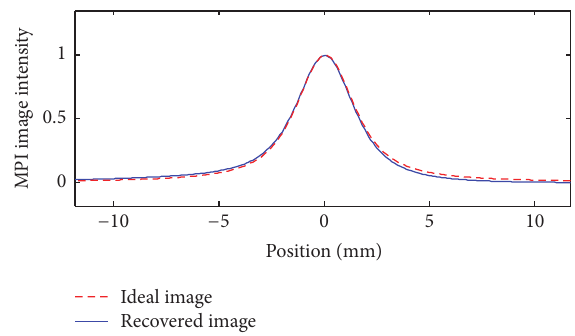
Figure 2: Recovery of the lost constant image, for the example of Figure 1, finding the global minimum of the